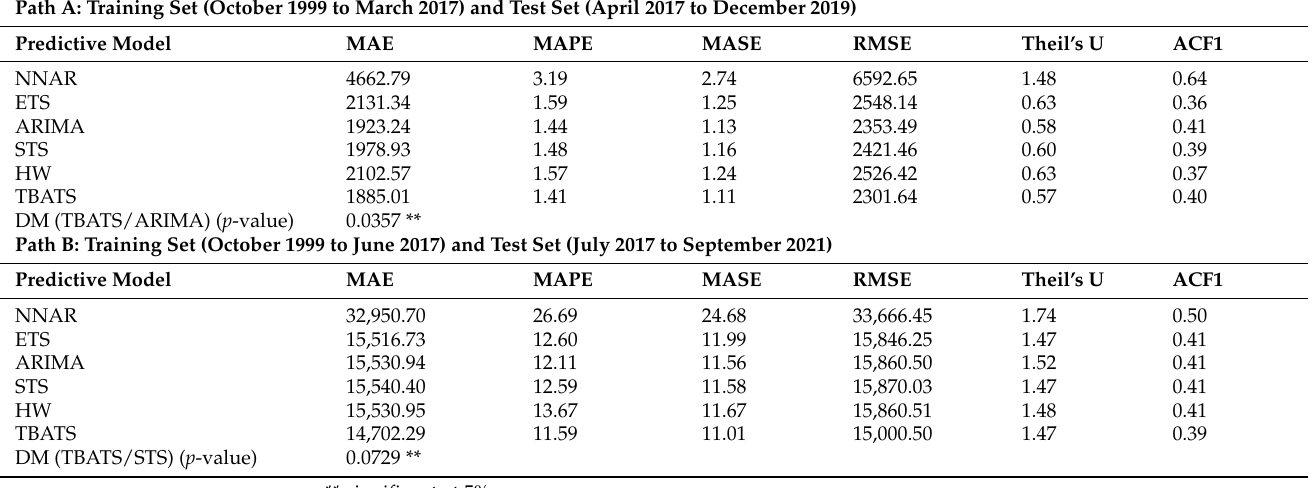
Figure 6. Model performance over testing window (e-commerce retail share, path A): TBATS (panel a ), and NNAR (panel b ). Source: estimation results.